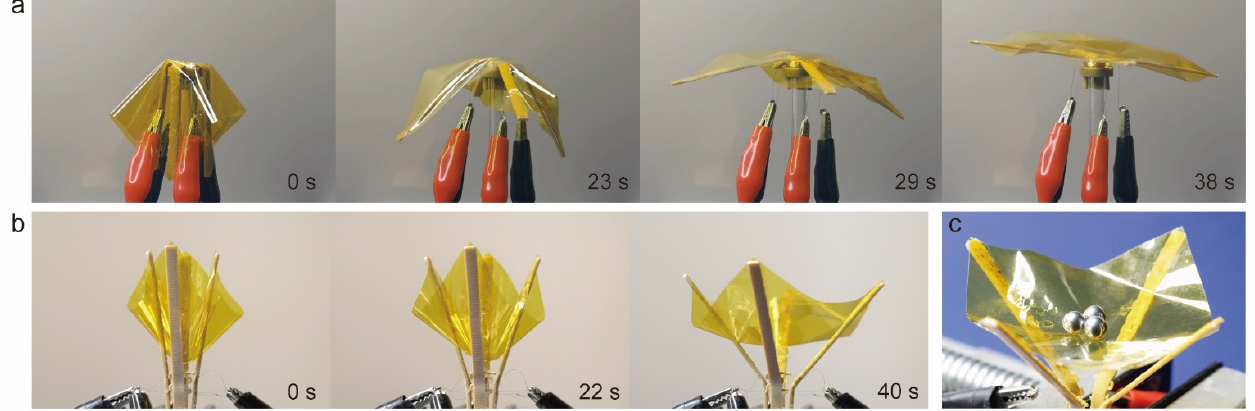
Figure 9. The deployable structure of shape memory PEEK. ( a ) An experimental simulation of deployed drag sail. ( b ) A mimetic catcher with deployed joints. ( c ) The expanding film capturing and loading the stuff.